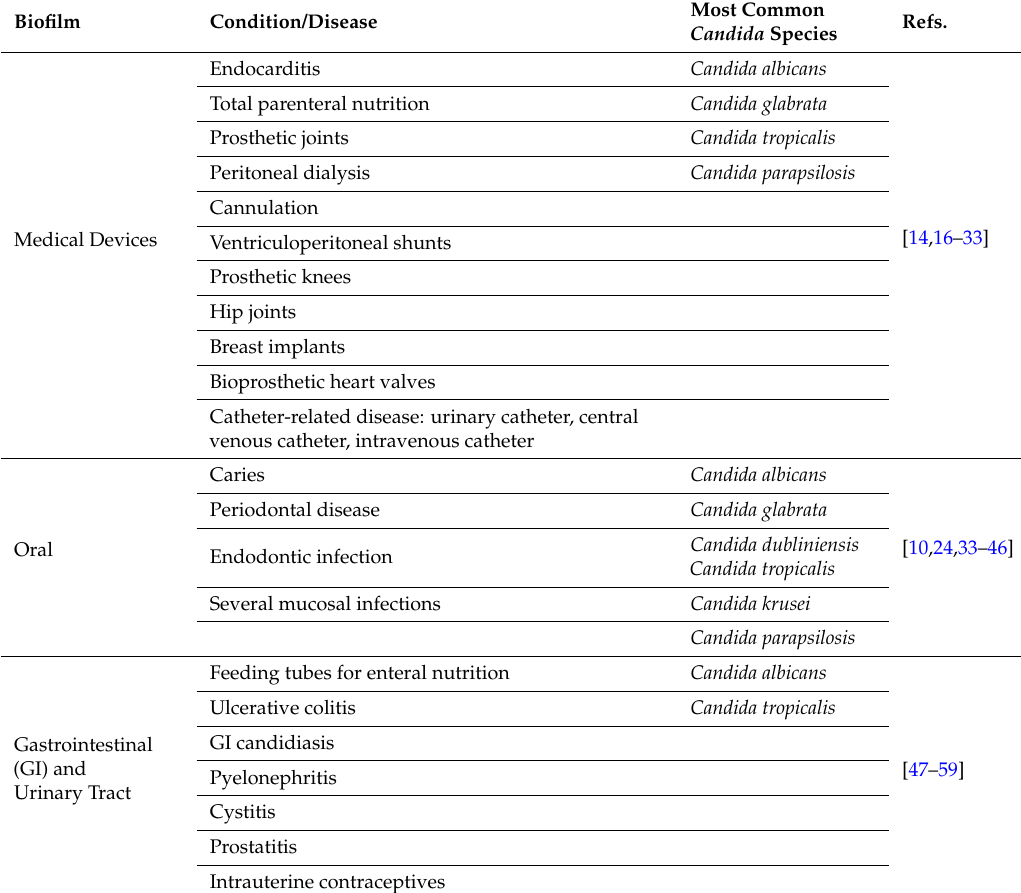
Table 2. Localization, condition/disease and most common species found on several Candida